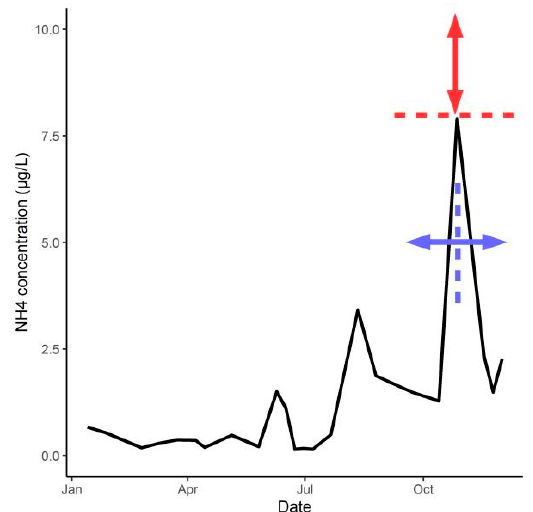
Figure A1. Illustration of the temporal (blue) and intensity (red) uncertainty of the “true” peak VS measured peak, here with the example of ammonium (NH 4+ ).